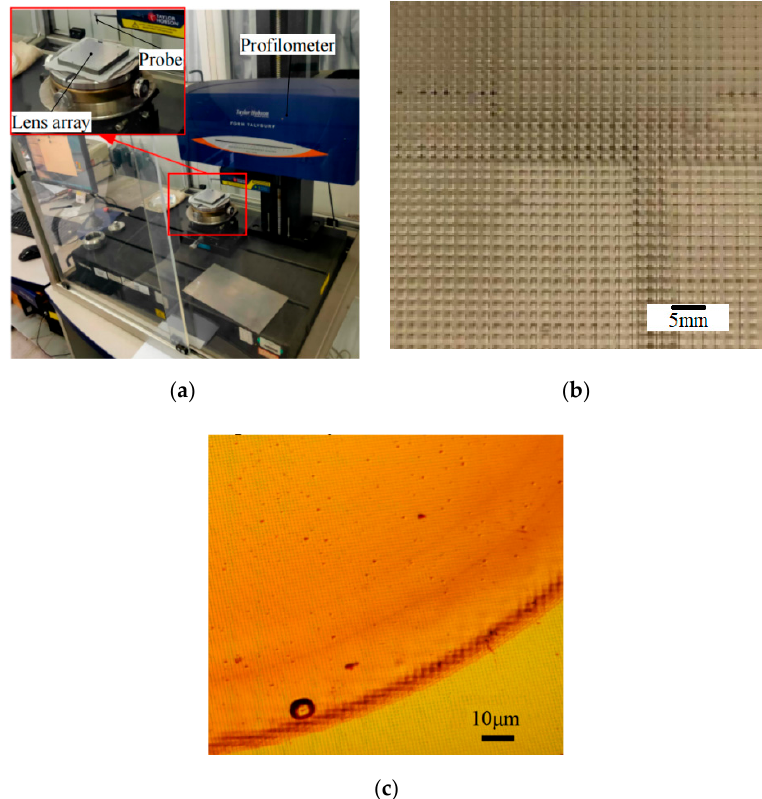
Figure 7. Physical pictures of detection system and components. ( a ) Physical photo of the detection system. ( b ) Infrared lenslet array physical partial photo. ( c ) Micrograph of the stylus crossing area of the lens.